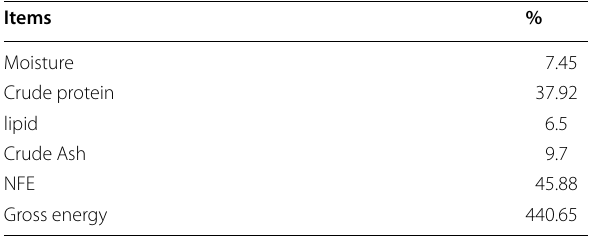
Based on NRC (1993) for protein, lipid and carbohydrate